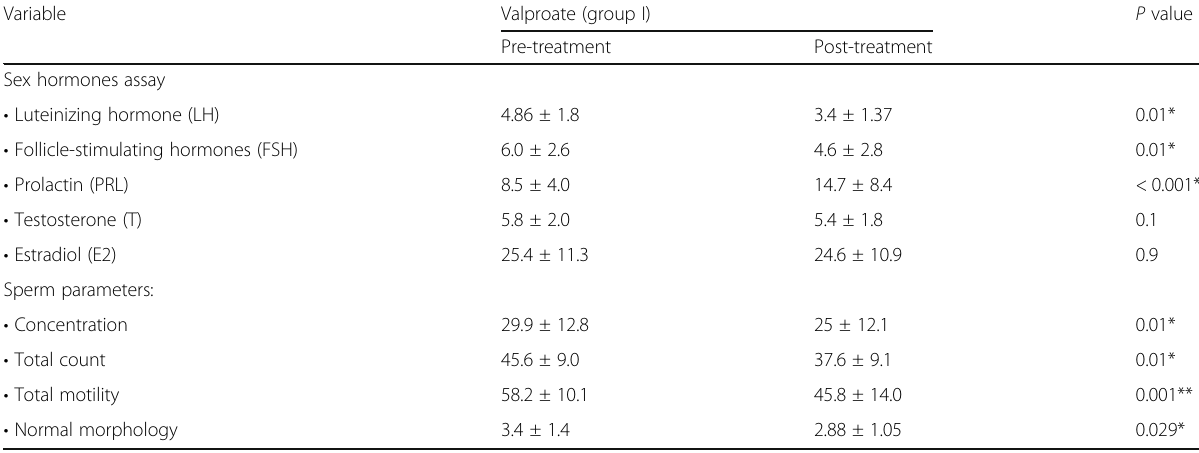
Table 2 Comparison between pre- and post-valproate (group I) treatment regarding sex hormone assay and sperm parameters Variable